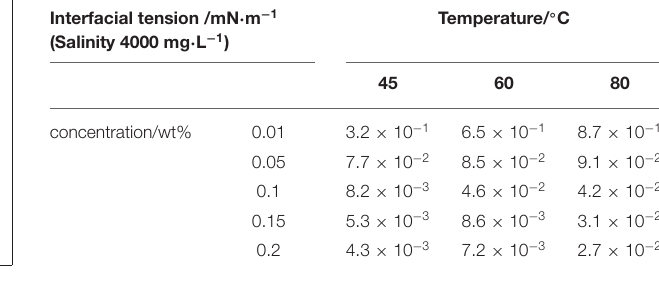
TABLE 3 | Statistical table of salt resistance of Janus nanosheets. Interfacial tension /mN · m − 1